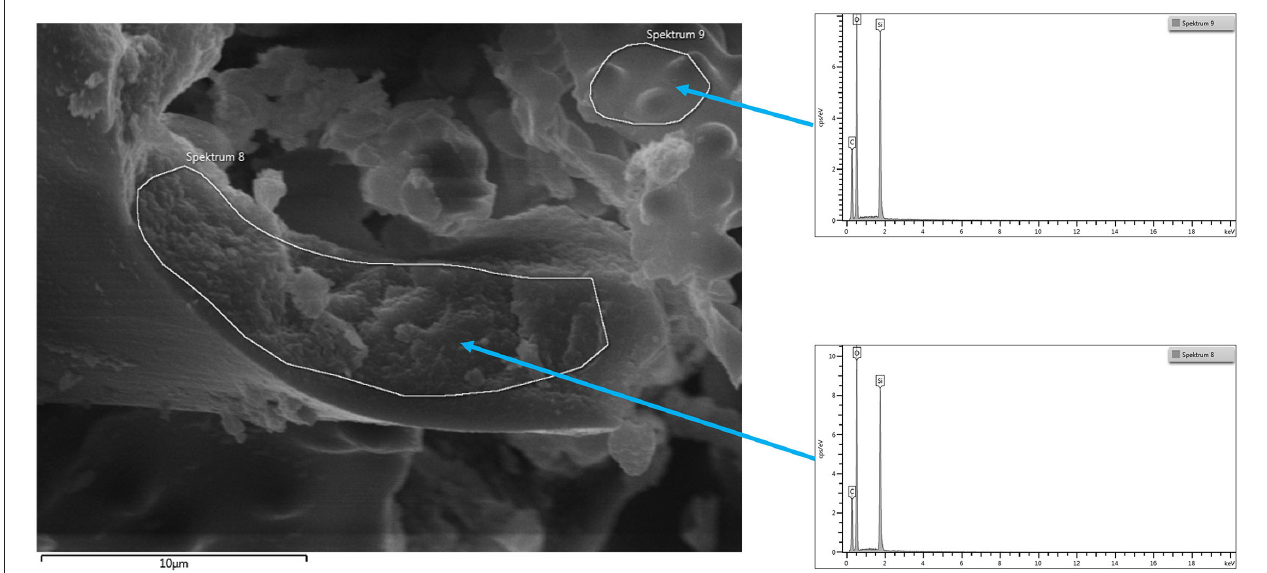
FIGURE 5 | SEM micrograph common horsetail final sample with areas taken for EDX.